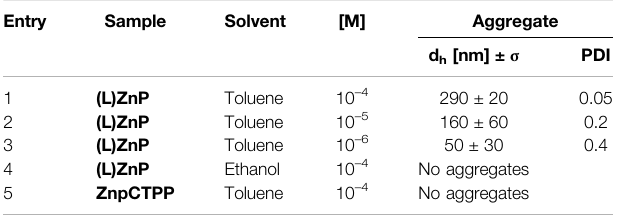
TABLE 1 | Dynamic light scattering (DLS) analysis of (L)ZnP(-) and the achiral ZnpCTPP in different solvents and concentrations.